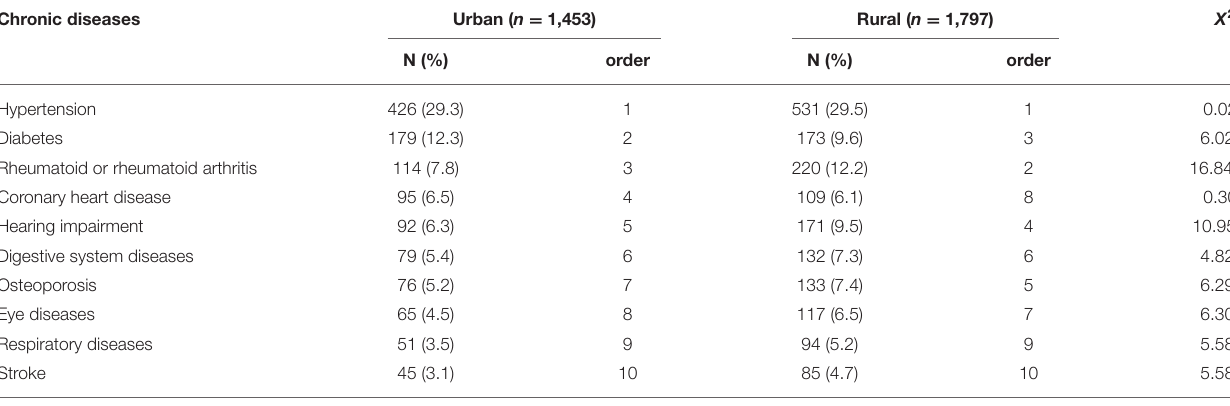
TABLE 1 | The urban–rural differences of the 10 most prevalent chronic diseases among older adults. Chronic diseases